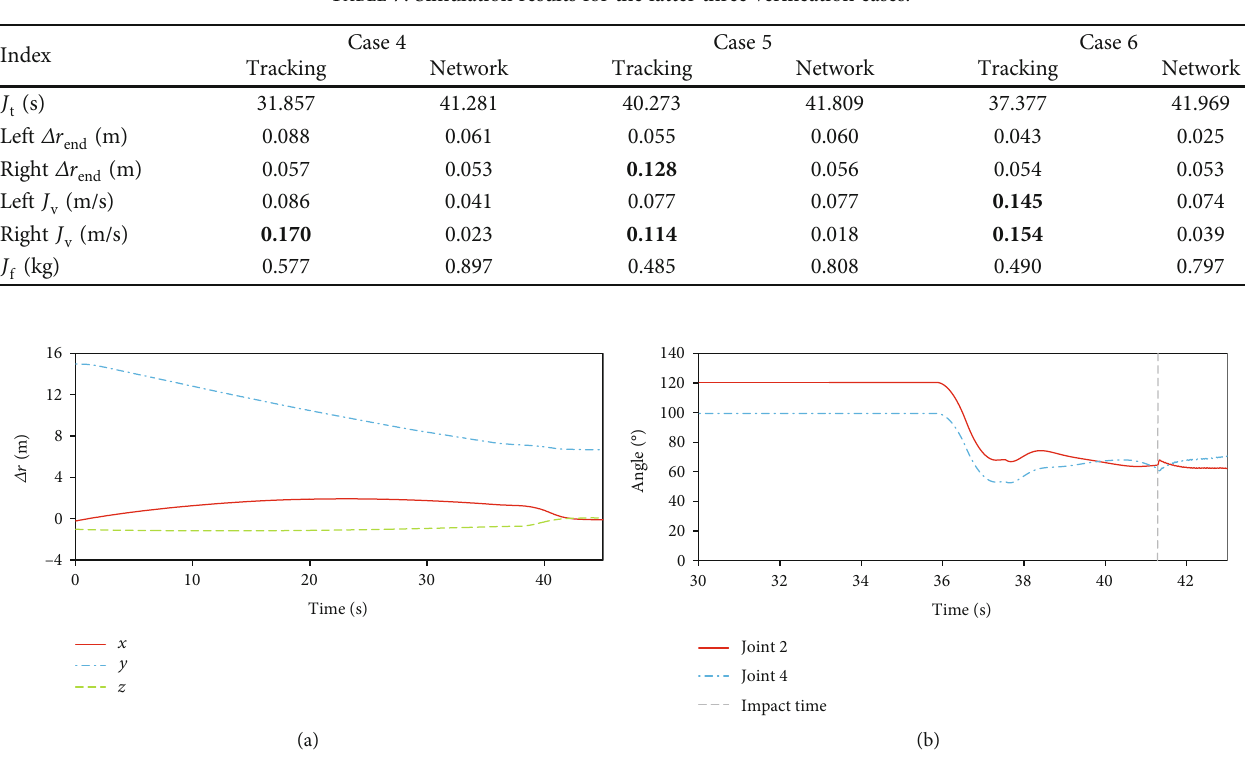
Figure 12: Relative orbit motion and manipulator joint motions in case 5. (a) Relative position expressed in S 4 of the left